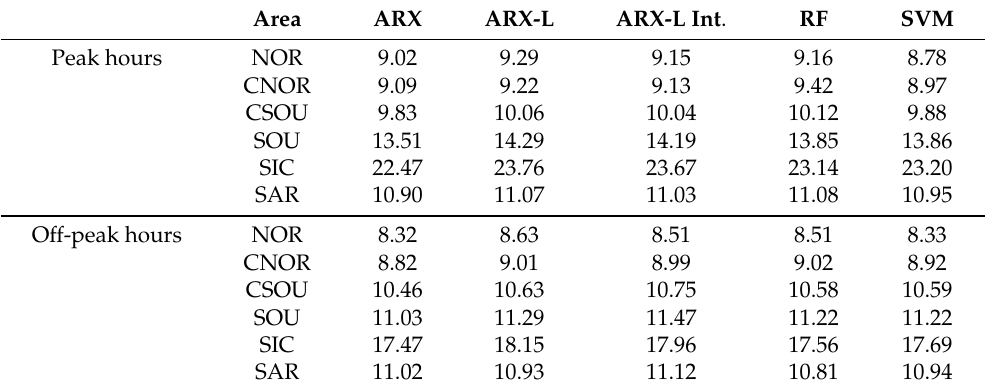
Table A2. Mean value of MAPE over peak (14 h) and off-peak (10 h) hours. Values are obtained as the percentage ratio of MAE to the average price observed over the prediction horizon in the same hour group (peak and off-peak).